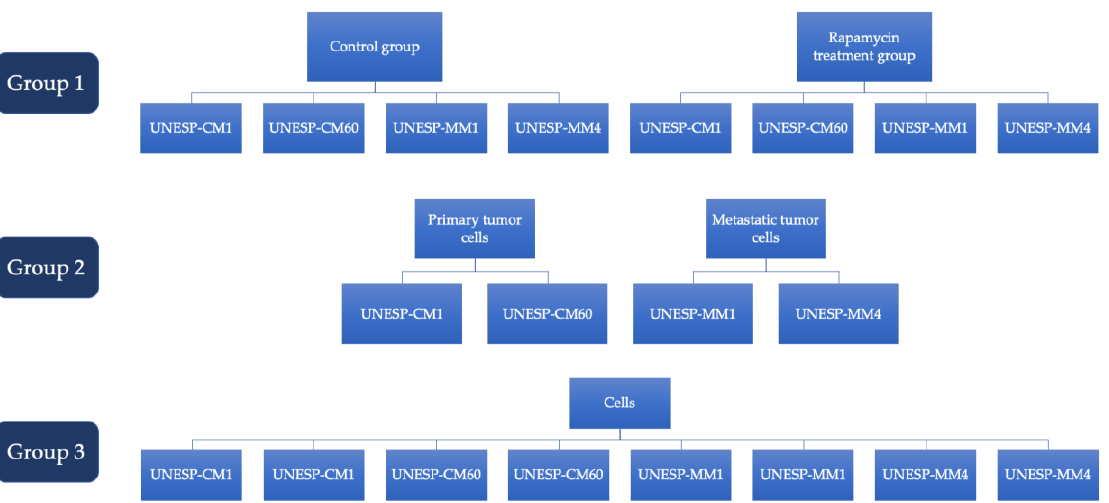
Figure 7. Experimental groups to perform RT-qPCR analysis.